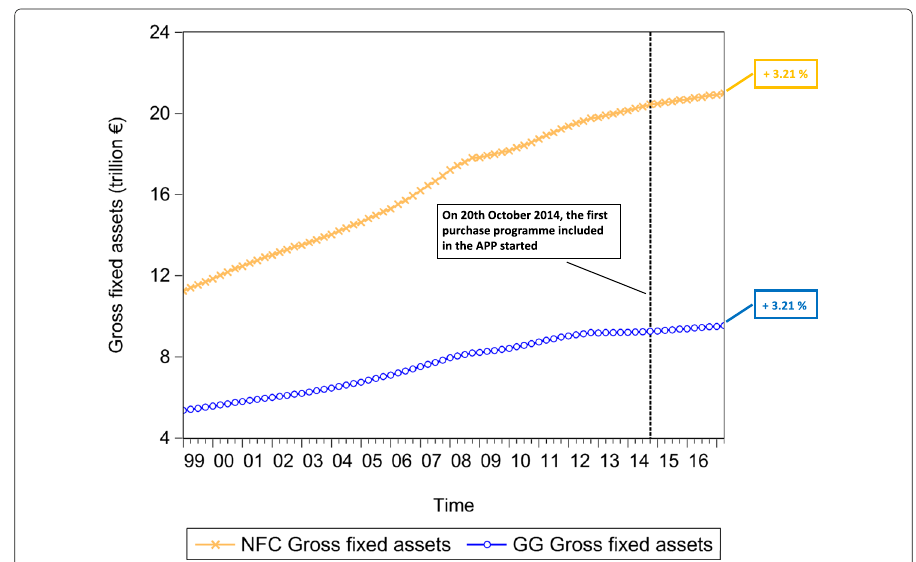
Fig. 16 Non-Financial Corporation and General Government gross fixed assets; 1999Q1-2017Q2. Time series of the euro area non-financial corporation and general government gross fixed assets, over the reference period 1999Q1-2017Q2. The vertical line corresponds to the beginning of the first purchase programme (3rd Covered Bond Purchase Programme, CBPP3) included in the APP, started in 2014Q4, while the percentages on the right-hand side of the graph correspond to our estimate of the growth rate of euro area non-financial corporation and general government gross fixed assets, since the initiation of QE. Data source: (European Central Bank 2017b)